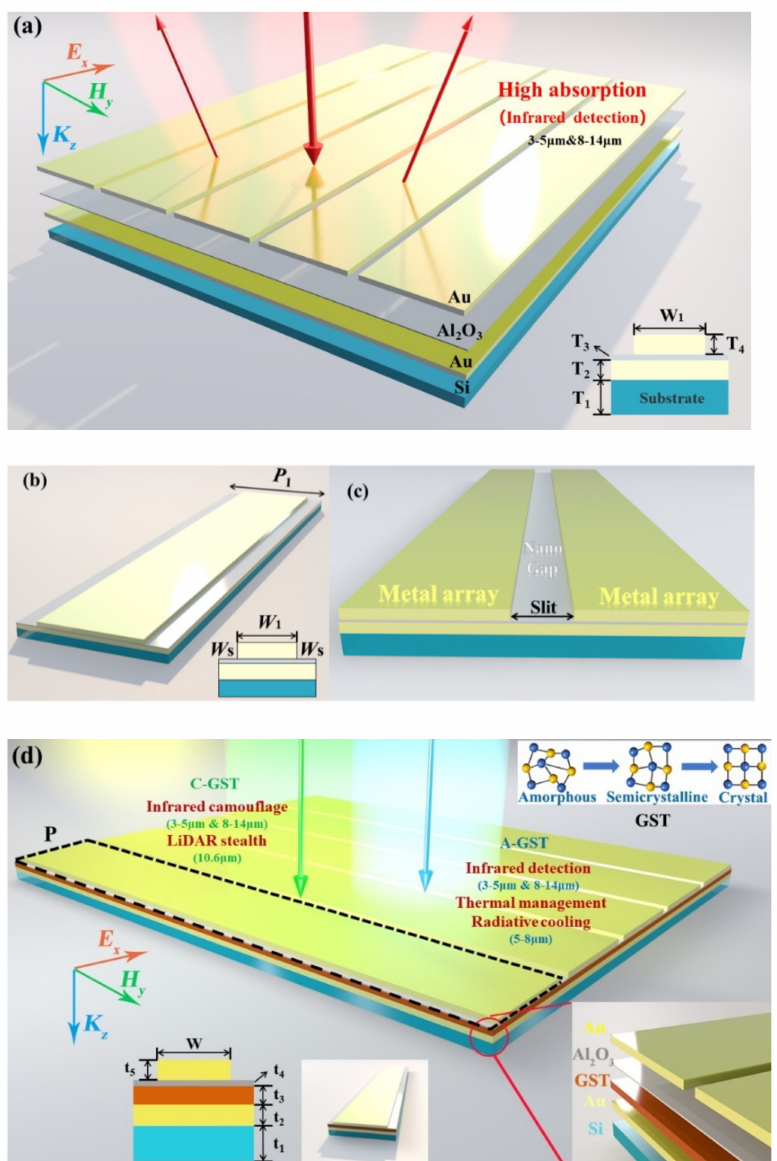
Figure 1. Schematic diagram of the geometric model of the designed multifunctional device: ( a ) three-dimensional view of the periodic four-layer structure, ( b ) view of the four-layer unit struc- ture (with the metal array as the center of symmetry) and its dimensions, ( c ) view of the five-layer unit structure (with the slit as the center of symmetry) and ( d ) 3D view of the periodic five-layer